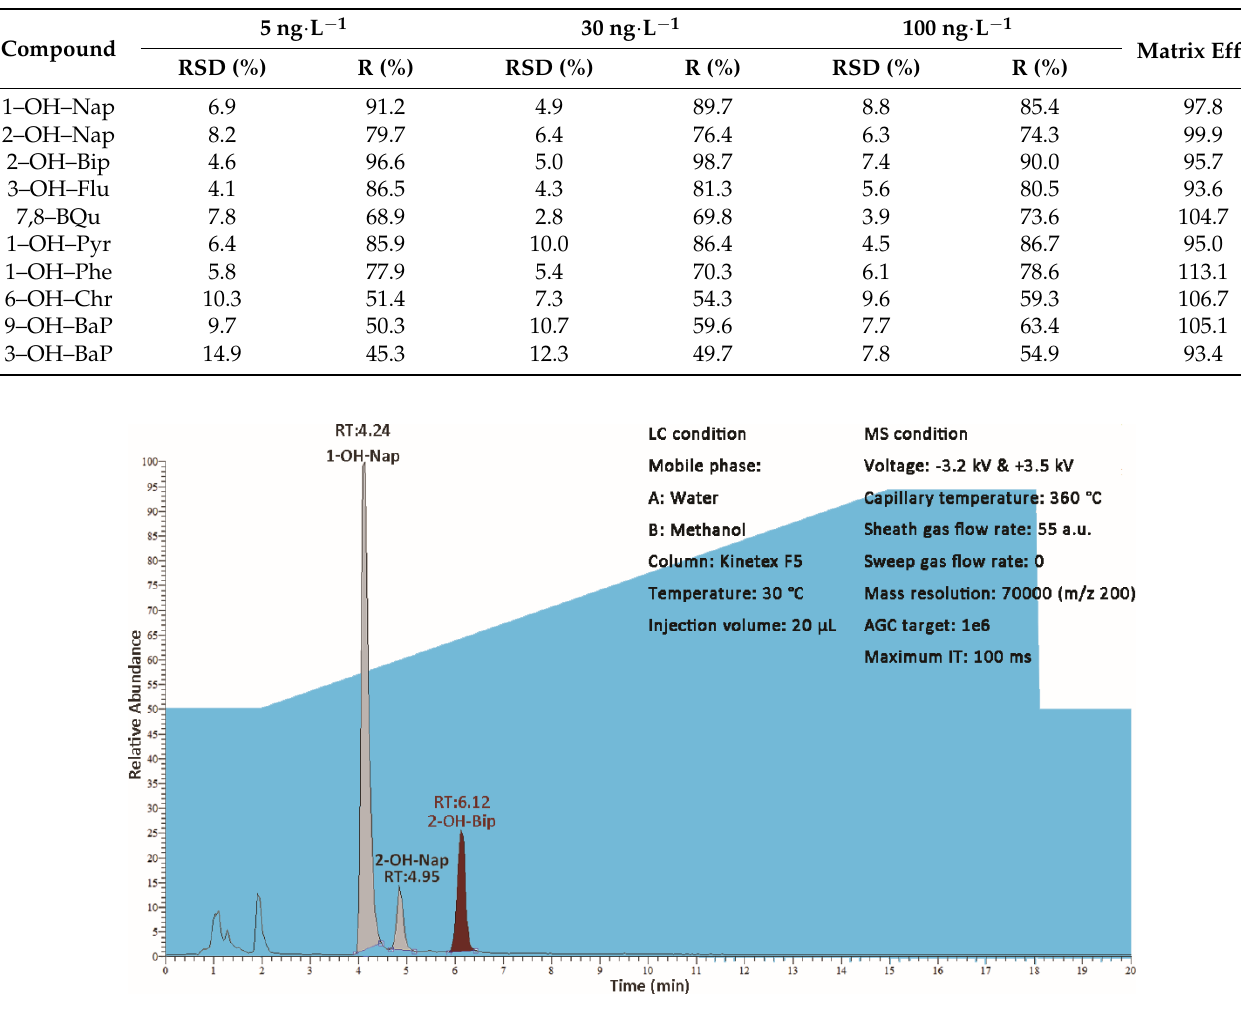
Figure 5. The EIC chromatogram which had the maximum concentration of 1–OH–Nap. Statistics of compounds with a concentration above MDL are listed in Table 5. The result shows that in nearly half of the samples the concentration of all targets was below MDL. Additionally, the median concentration was around 2.5 ng · L − 1 , which suggests that the concentration in most of the lake is around 2.5 ng · L − 1 or even lower. However, the maximum concentration was much higher, which suggests that the concentration was highly unevenly distributed. Table 5. Maximum and median concentrations, number, and rate of concentrations above MDL and the sample number with the maximum